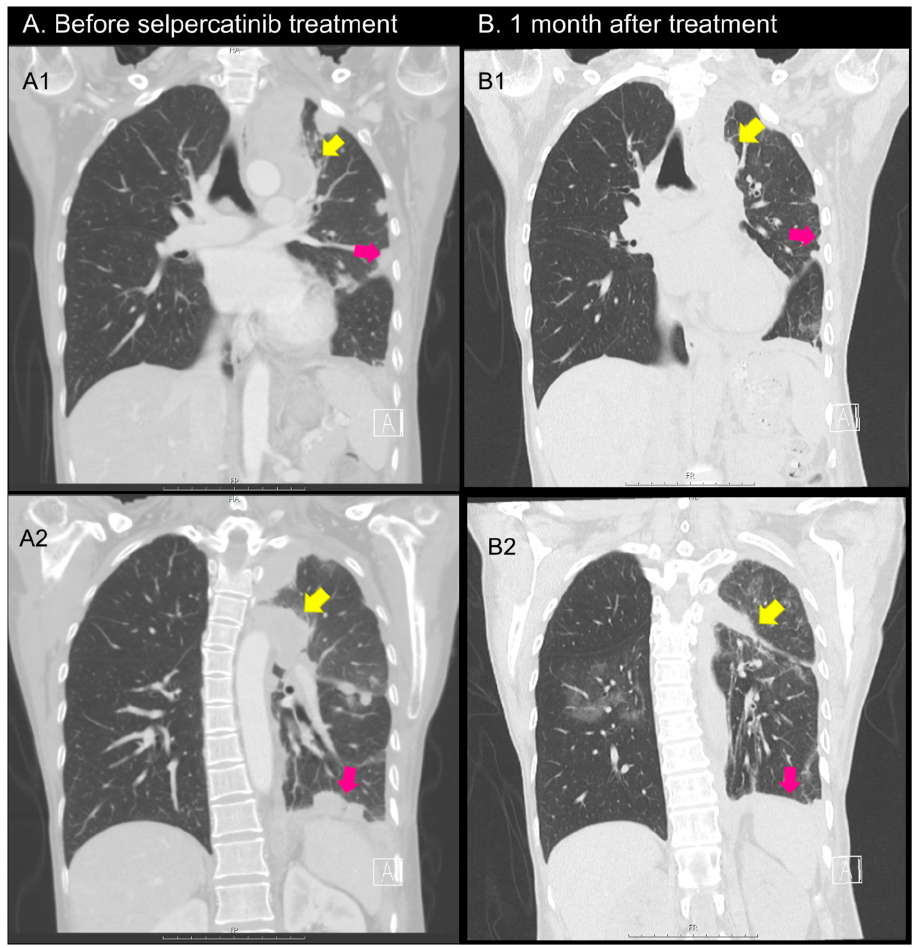
Figure 5. Before and at one month after selpercatinib treatment CT-scan of the patient in Case 4. Before treatment, there were metastatic lesions at hilar lesion, pleural, and lung parenchyme ( A1 , A2 ). After the treatment, all of them showed regression ( B1 , B2 , yellow and purple arrows).